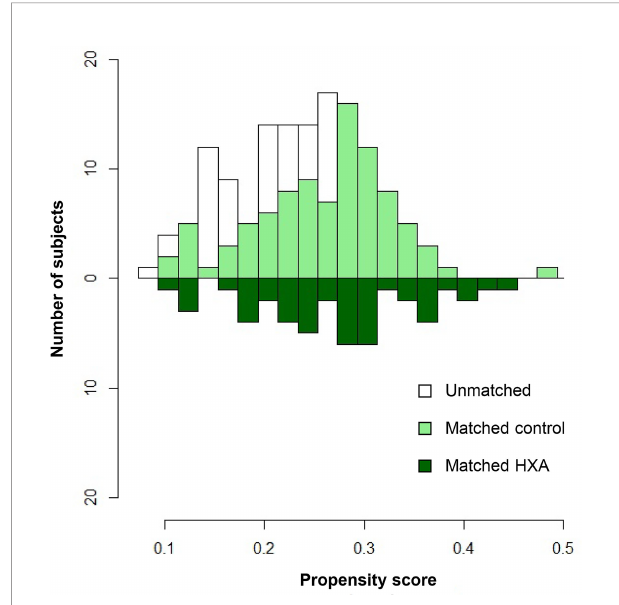
FIGURE 4 | Mirrored histogram of propensity scores for patients who underwent skull base reconstruction with the conventional multilayer technique and combined use of hydroxyapatite with the multilayer technique. Colored areas represent propensity-matched cohorts.